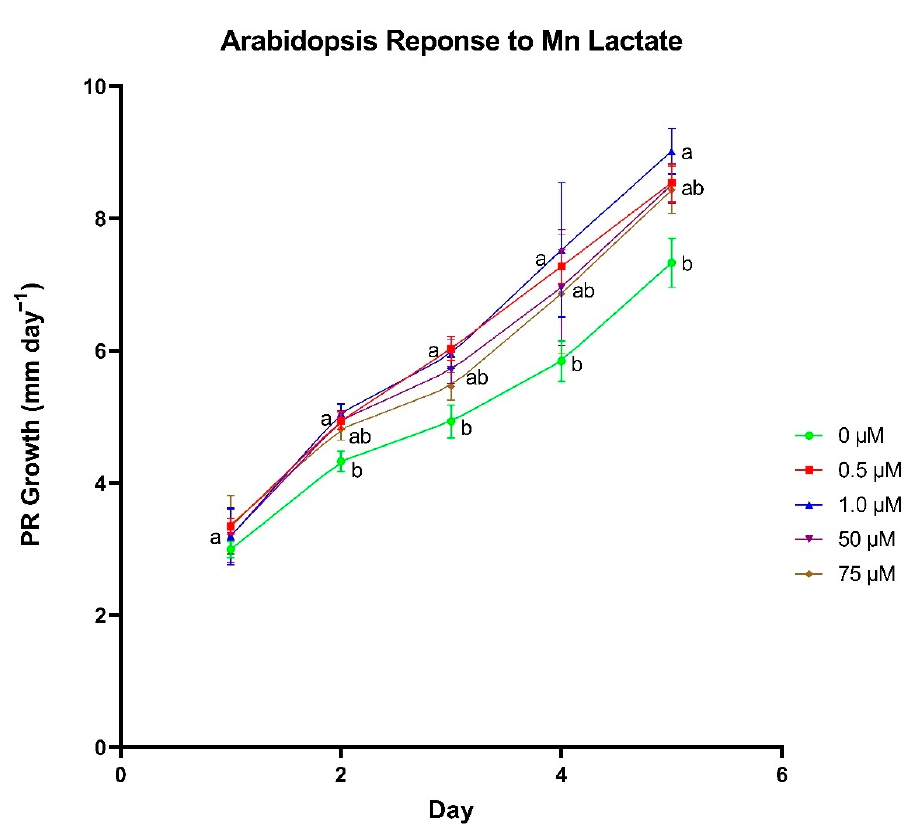
Figure 2. The effect of manganese (Mn) lactate concentration on primary root (PR) growth rate in Arabidopsis thaliana . Differences between means were compared using Tukey’s Honest Significant Difference test, where different letters indicate a statistically significant difference between treatment concentrations in their respective day of growth. Error bars denote means ± SE ( n =